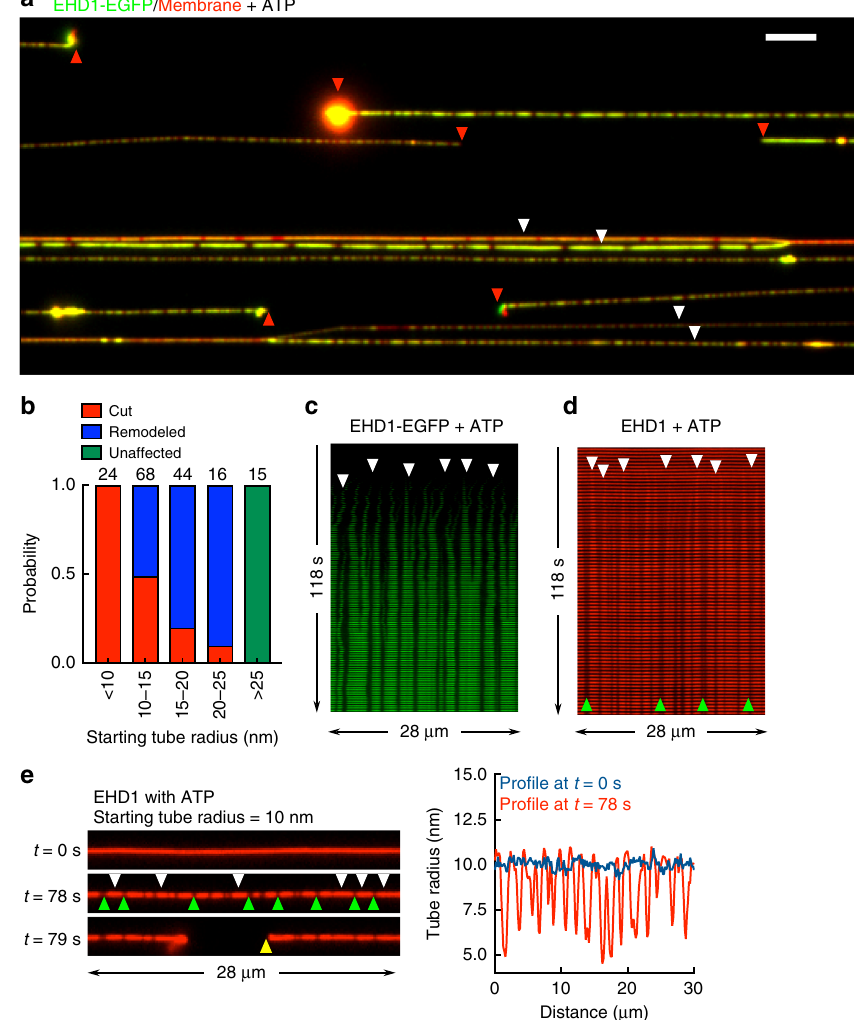
Fig. 6 Membrane fi ssion induced by ATP hydrolysis. a Representative fl uorescence micrograph after 5 min of adding EHD1-EGFP with ATP to templates (see Supplementary Movie 1). Red arrowheads mark cut ends of tubes and white arrowheads mark tubes that remain uncut. Scale bar = 10 μ m. b Tube remodeling and fi ssion probability as a function of starting tube radius for the indicated numbers of tubes. c Representative montage of tube images acquired in the GFP channel showing the nucleation (white arrowheads) and growth of EHD1-EGFP scaffolds in presence of ATP (see Supplementary Movie 3). d Representative montage of tube images acquired in the membrane channel showing the expansion of bulges (white arrowheads). White arrowheads mark the site of onset of bulging and green arrowheads mark sites of tube thinning. e Frames and associated line pro fi les from a representative movie acquired in the membrane channel showing the bulged (white arrowheads) and thinned-down (green arrowheads) sites on a tube, before fi ssion (yellow